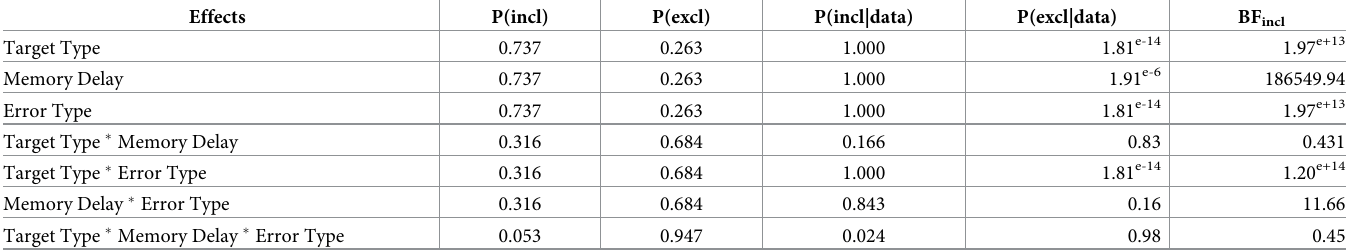
Table 6. Error rates